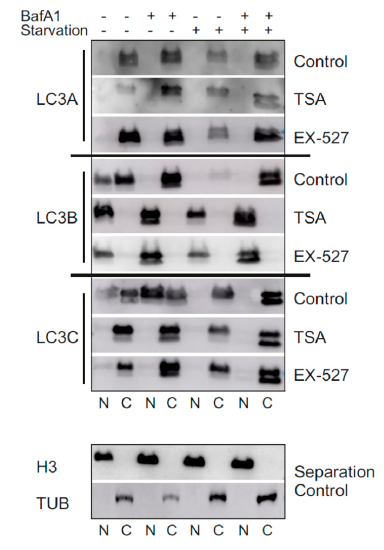
Figure 7. Western blot analysis of the cellular localization of LC3A, LC3B and LC3C in response to pharmacological sirtuin inhibition under normal and starvation conditions. Primary human fibroblasts were grown under normal or starvation conditions and were treated with BafA1, Ex527 or TSA, as indicated. Nuclear and cytosolic fractions of the cells were prepared and investigated for their protein content of LC3A, LC3B and LC3C. The nuclear marker histone H3 and the cytosolic marker tubulin were analyzed in selected fractions for general separation quality control purposes.